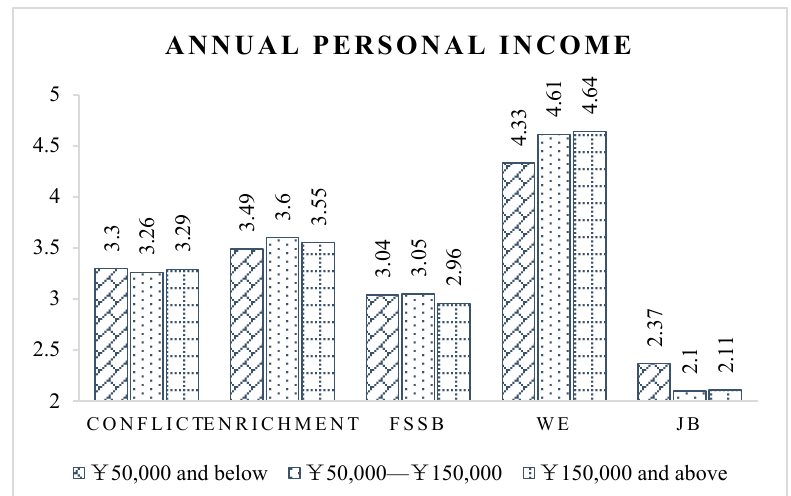
Figure 5. Latent variable scores of different income groups.